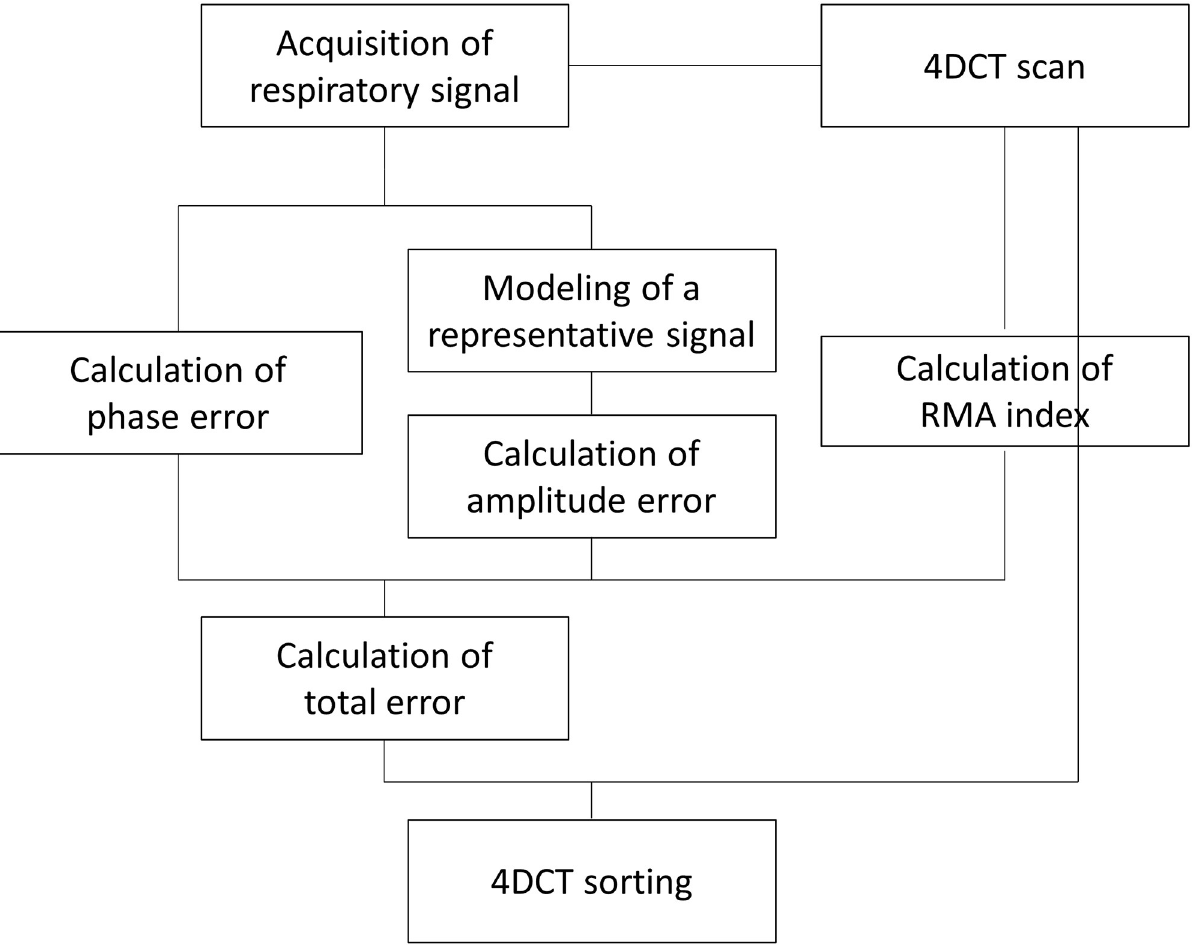
Fig 10. Conceptual workflow of the proposed amplitude-weighted phase sorting method with image